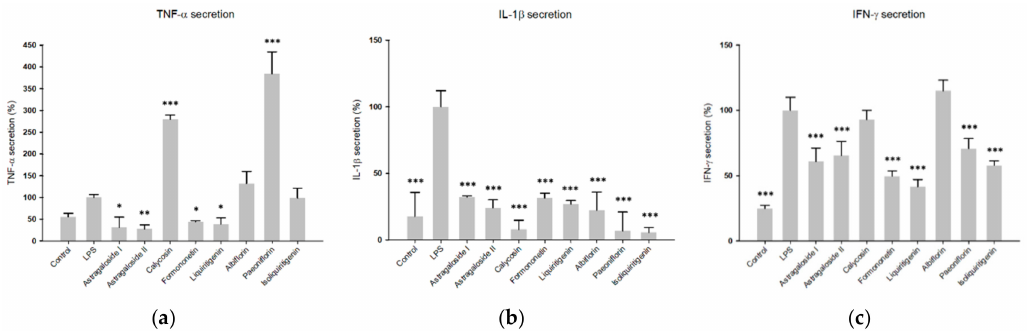
Figure 6. Inhibitory e ff ects of the identified compounds in HQJZT on production of ( a ) TNF- α , ( b ) IL-1 β and ( c ) IFN- γ . Concentration of the compounds: 6.25 µ g / mL; n = 3; mean (SD); Control: unstimulated cells; LPS: LPS-stimulated cells (1 µ g / mL) without treatment; * ( p < 0.05); ** ( p < 0.01); *** ( p < 0.005); significant di ff erences obtained by ANOVA with Dunnett-T